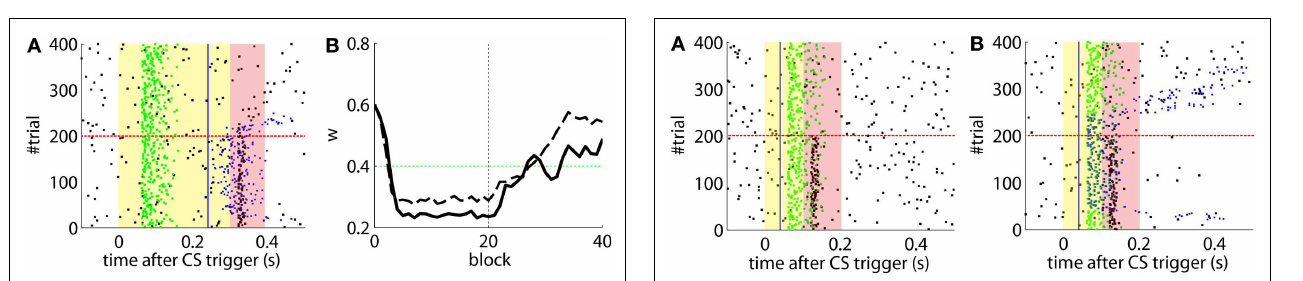
FIGURE 6 | Results with and without delayed NOI. (A) Raster plot with the output of the model with the delay of the NOI set to 0s. (B) Trajectory of w in the model with a delay of 100ms in the NOI (solid line) and with no delay (dashed line).The horizontal green dotted line marks the level above which the model does not trigger any CRs. Blocks of 10 trials.